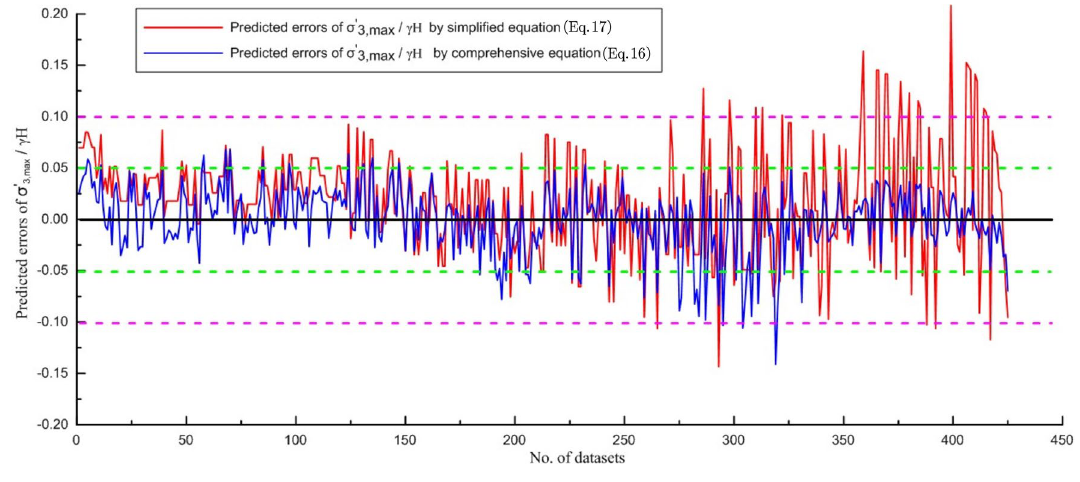
σ ′ 3,max γ H values from two quantitative correlations.